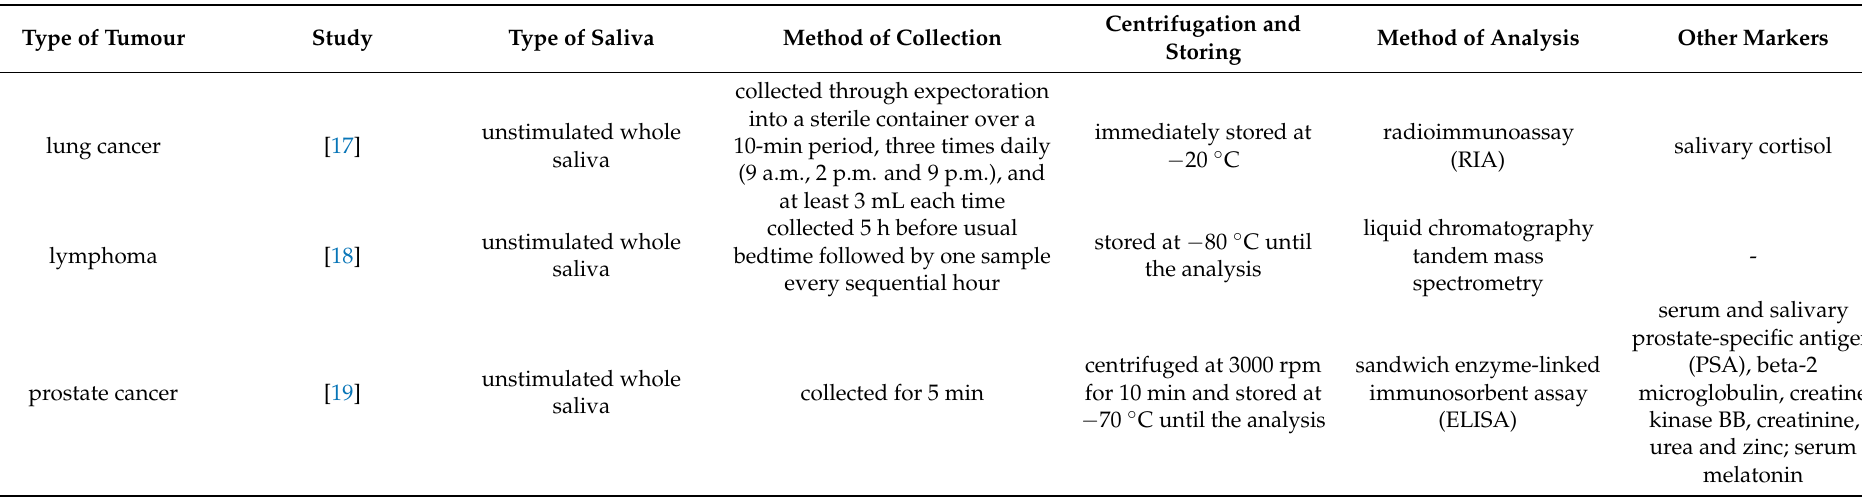
Table 3. Detailed characteristics of included studies considering methods of collection and analysis of